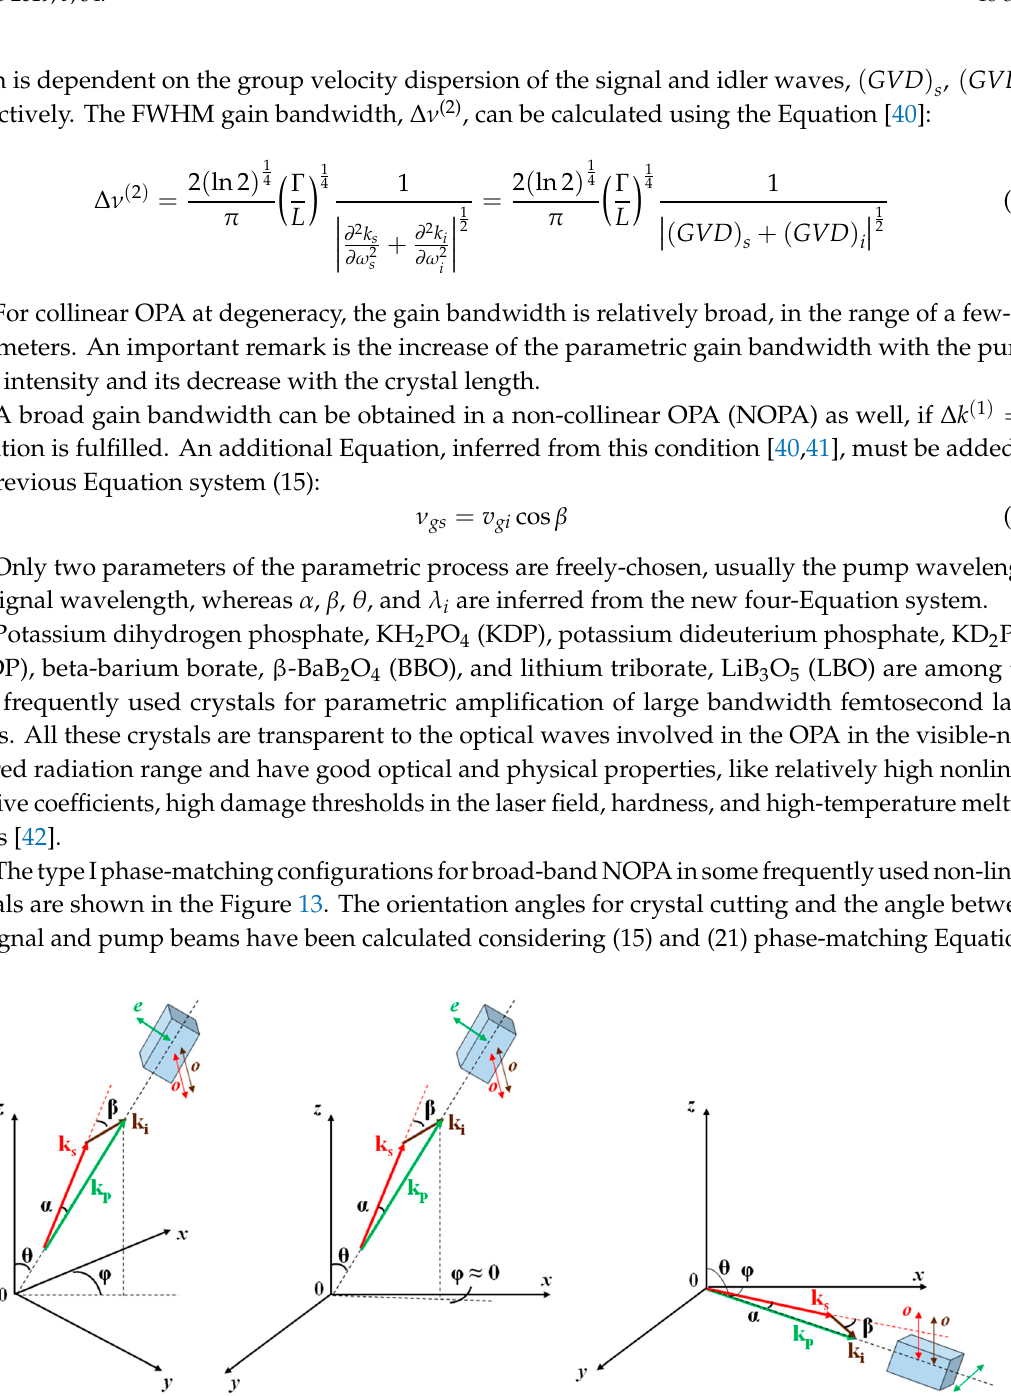
Figure 14. The simulated gain bandwidth in non-linear crystals for broad-band (BB) phase-matching NOPA compared with collinear narrow-band OPA, at given λ sc signal central wavelengths. Pump beam intensity, I p = 1 GW/cm 2 . Crystal lengths were chosen to get similar gains for all parametric processes. ( a ) BBO crystal, red line NOPA, black line collinear OPA, L BBO = 9.9 mm, 532 nm Nd:YAG